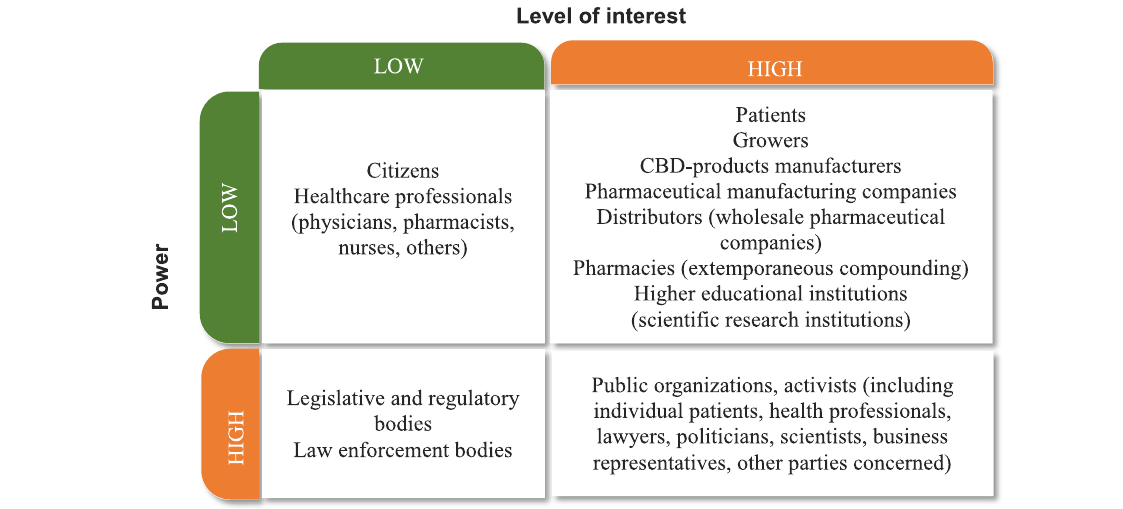
Fig. 7 Stakeholder power\interest grid on the potential market of medical cannabis in Ukraine. Note: Healthcare professionals (physicians, pharmacists and others), after medical cannabis legalization, are transferred into the status of stakeholders having high power and low interest, as they have a direct impact on the products accessibility for